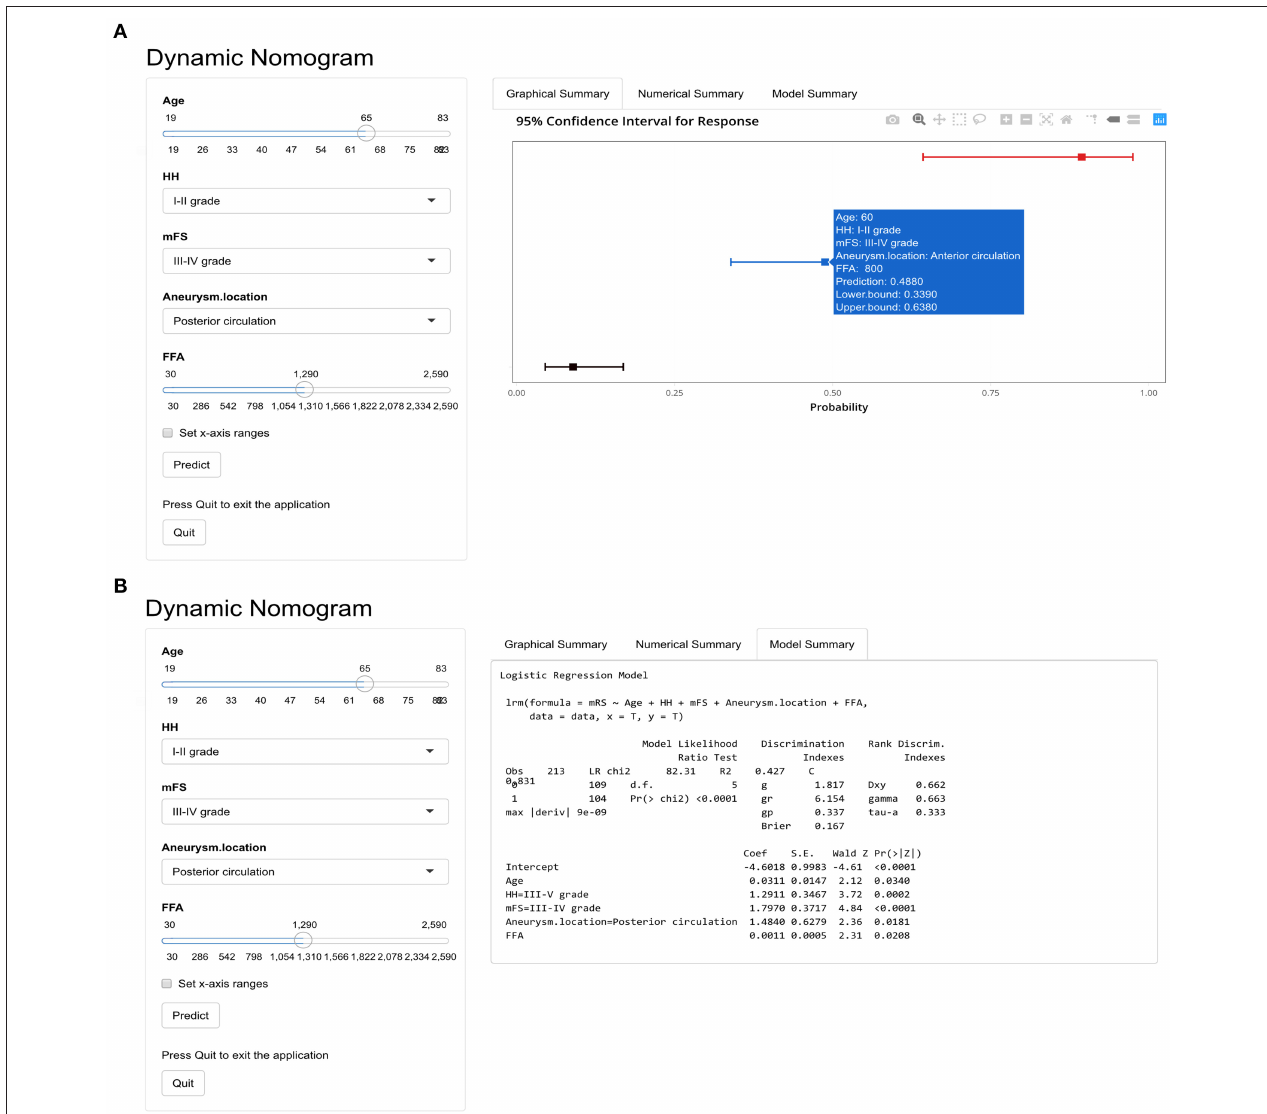
FIGURE 5 | The online calculator for an individualized prediction of 3 months poor outcome based on the nomogram. (A) The output of graphical summary after calculation. (B) Model summary including the formula based on the logistic regression and parameters.